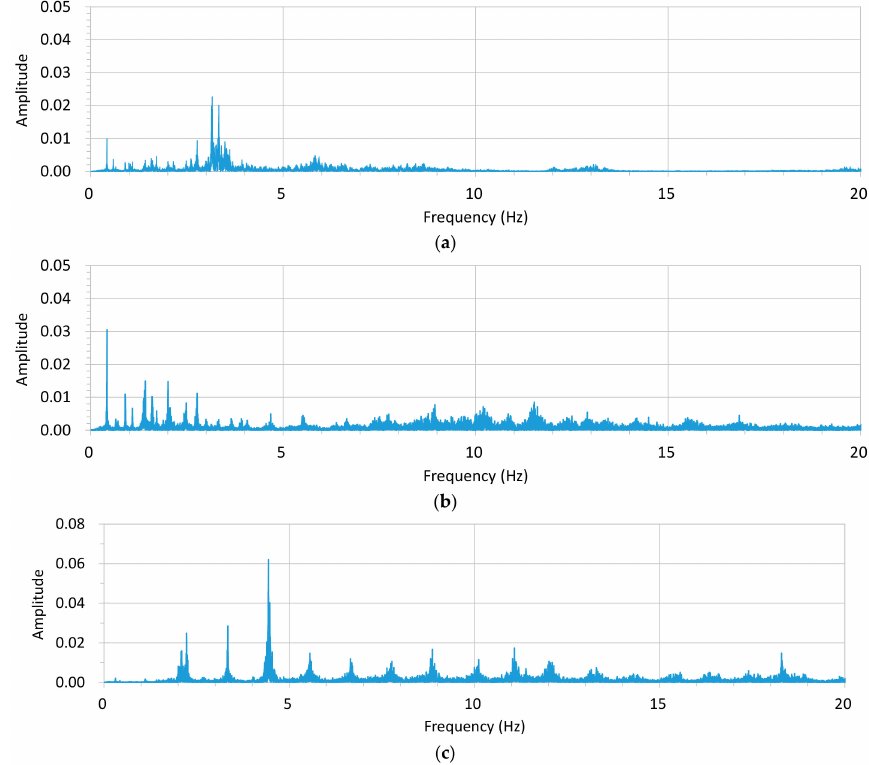
Figure 10. Fourier amplitude spectra of measured accelerations. ( a ) Top of the pylon (longitudinal direction). ( b ) Center of the span (vertical direction). ( c ) Cable (horizontal